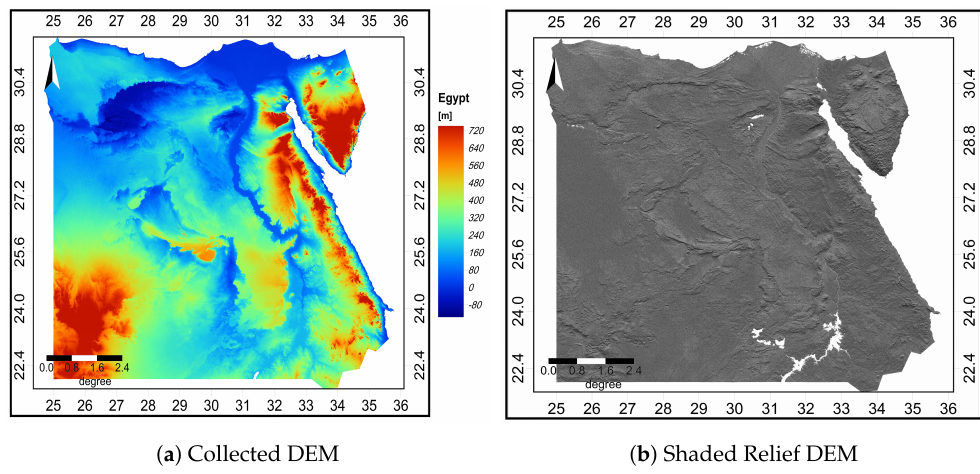
Figure 5. ( a ) ASTER SRTM-DEM with 30 m spatial resolution by the USGS. ( b ) Shaded-relief images utilized for automatic lineament